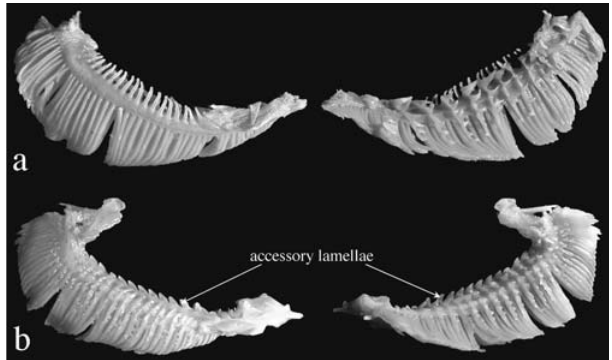
Fig. 6. Lateral (left) and medial (right) views of 1st gill arch. a. Leptodoras copei , ANSP 162466 (SL 141.5 mm). b. Leptodoras cataniai , ANSP 161532 (SL 148 mm).